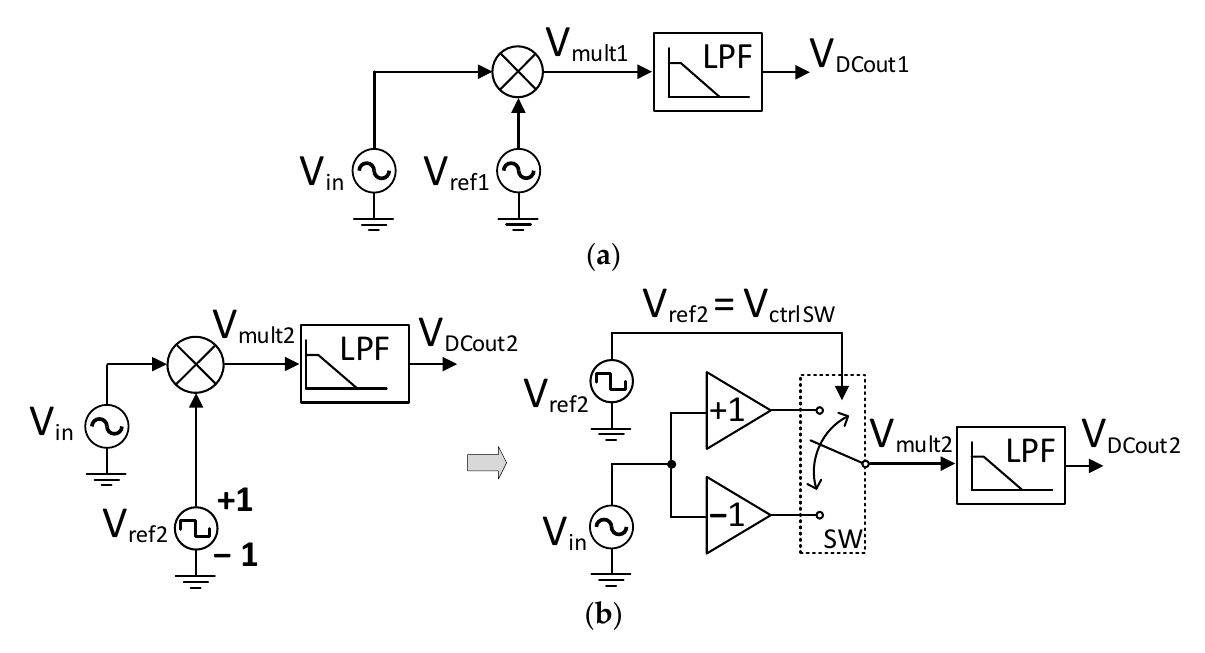
Figure 1. Basic block diagram of a phase-sensitive detector (PSD): ( a ) using conventional analog multiplication; and ( b ) multiplying by a ±1 square wave employing a switched multiplier.